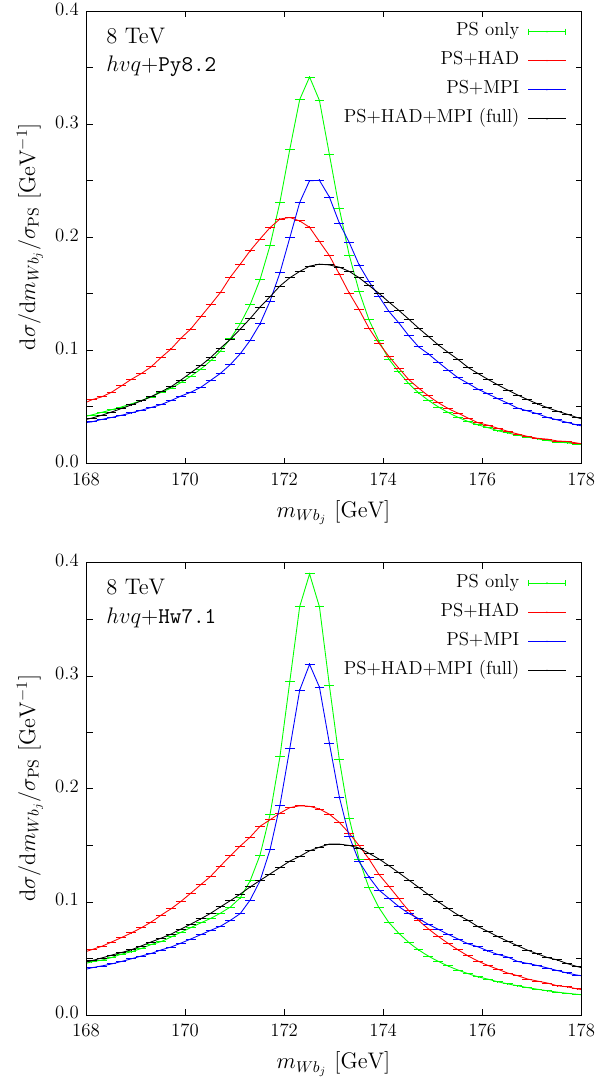
Fig. 7 d σ/ dm Wb distribution obtained with h v q interfaced with j Pythia8.2 (upper panel) and Herwig7.1 (lower panel). In green, the NLO+PS results; in red, hadronization effects are included; in blue, NLO+PS with multi-parton interactions (MPI); and in black, with hadronization and MPI effects. The curves are normalized using the NLO+PS cross section in the displayed